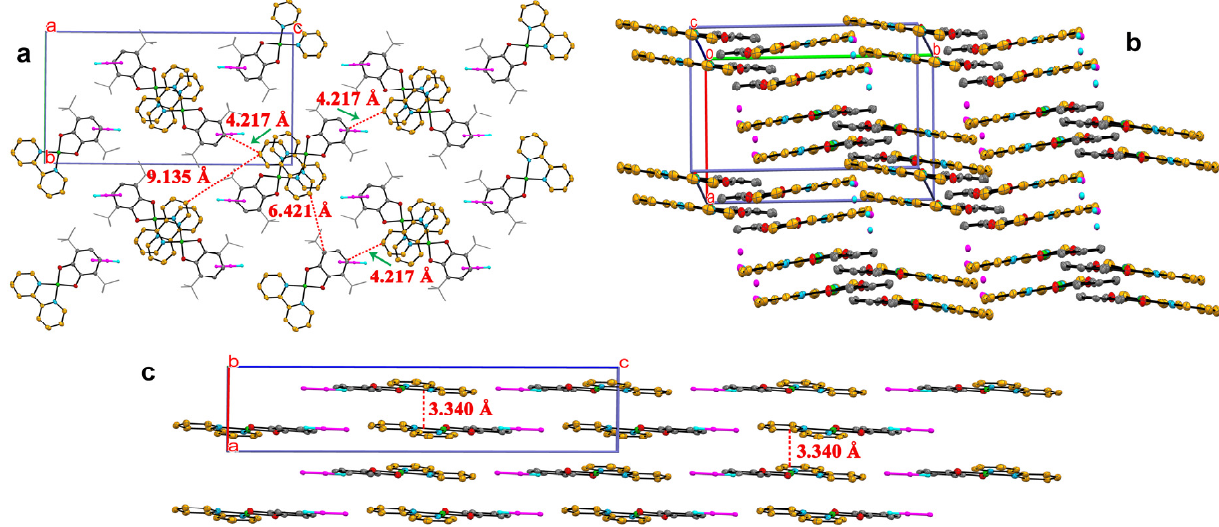
Figure 3. Views of crystal packing fragments of 1 (two unit cells) with 50% thermal probability ellipsoids. Tert -butyl groups ( b ) and hydrogen atoms are omitted for clarity. Carbon atoms of diimines are orange-colored. Views ( a ) and ( c ) demonstrate types of intermolecular contacts.